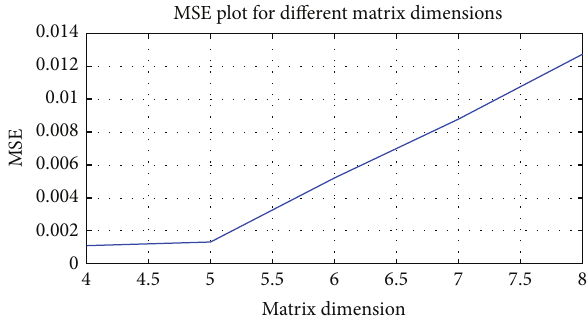
Figure 4: MSE plot of QRD for different matrix